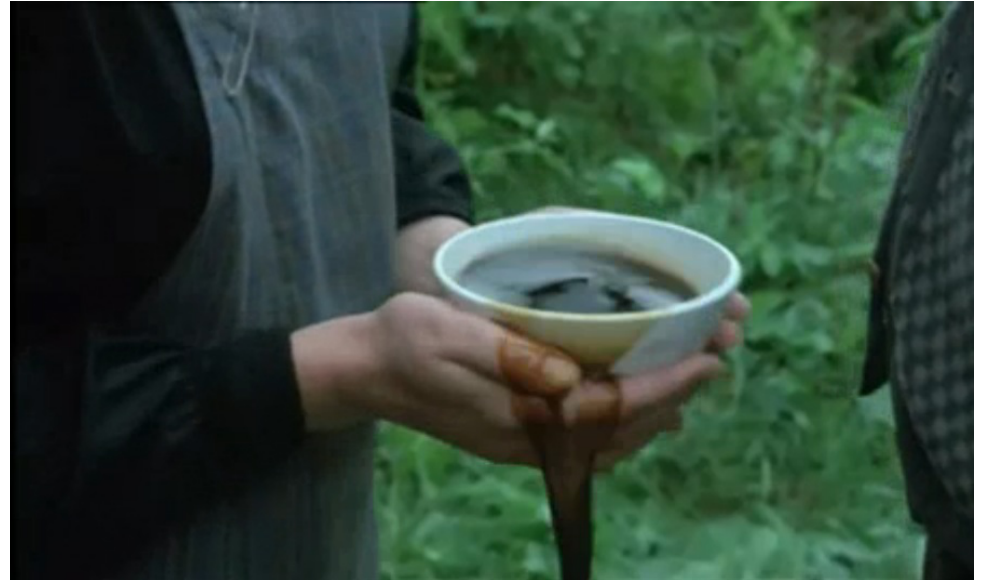
Figure 4: Robert Bresson: